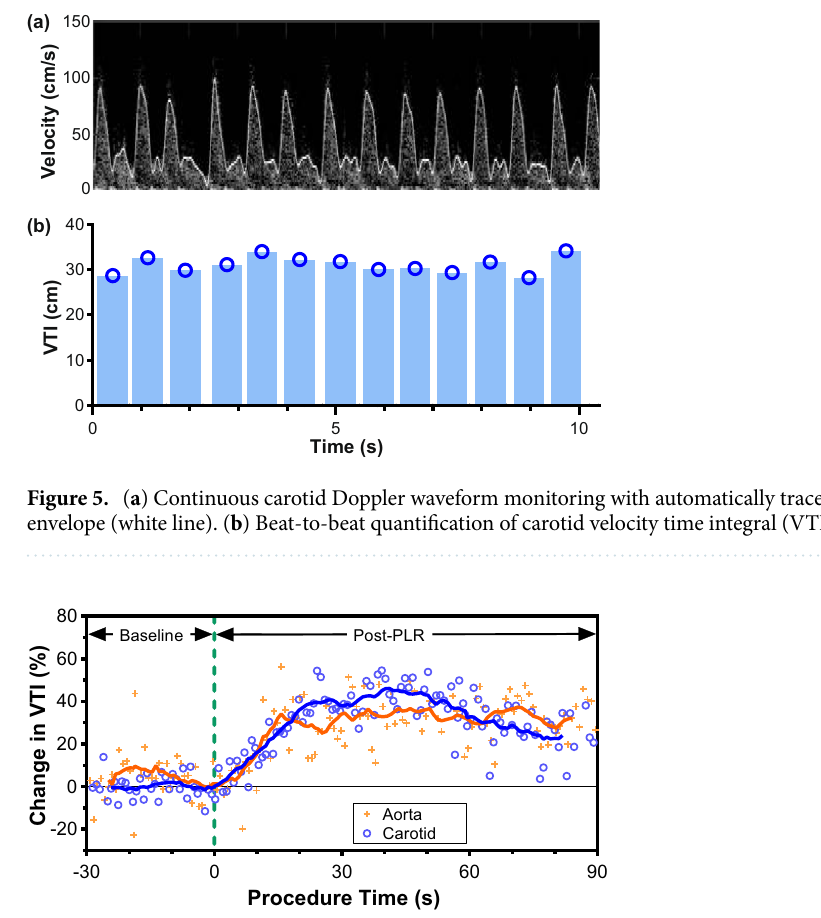
Figure 6. Time course of velocity time integral (VTI) following a passive leg raise (PLR) intervention to modulate cardiac preload in a healthy volunteer. The leg raise was initiated at t = 0 s (vertical dashed-line). VTI is calculated from Doppler waveforms acquired simultaneously from the carotid using the CW Doppler Patch (blue, open circles) and the descending aorta using PW Doppler (orange, crosses) and normalized to the mean VTI between − 10 and 0 s of baseline. Solid lines are moving average of 12